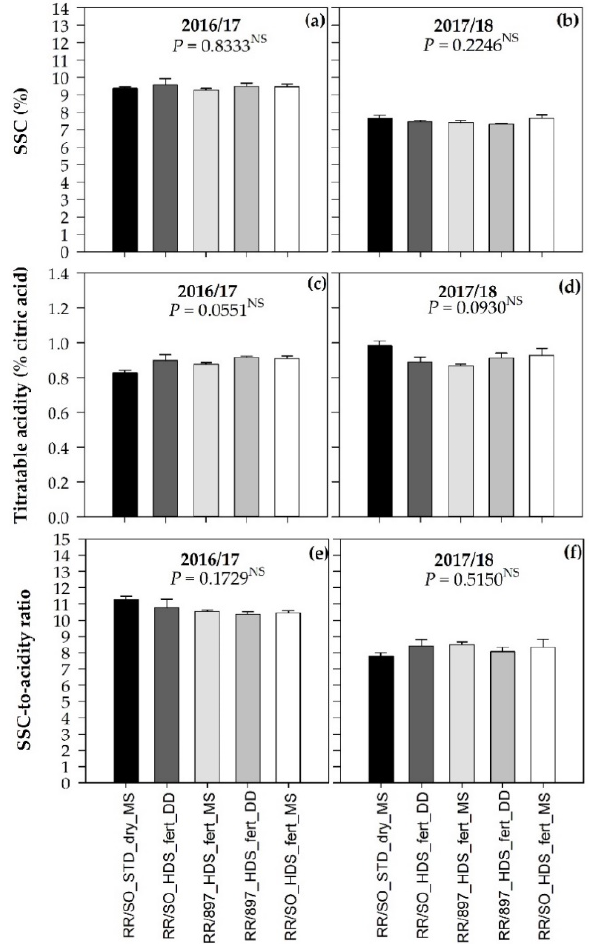
Figure 5. Soluble solids content (SSC) ( a , b ), titratable acidity ( c , d ), and SSC ‐ to ‐ titratable acidity ratio ( e , f ) of “Ray Ruby” grapefruit (RR) trees. Treatments: RR/SO_STD_dry_MS = Sour Orange (SO) rootstock + standard spacing (STD, 358 trees per ha) + dry granular fertilizer + microsprinkler (MS), RR/SO_HDS_fert_DD = SO rootstock + high density staggered (HDS, 953 trees per ha) + fertigation (fert) + drip (DD), RR/897_HDS_fert_ MS = US ‐ 897 rootstock + HDS + fertigation + microsprinkler, RR/897_HDS_fert_DD = US ‐ 897 rootstock + HDS + fertigation + drip, and RR/SO_HDS_fert_MS = SO